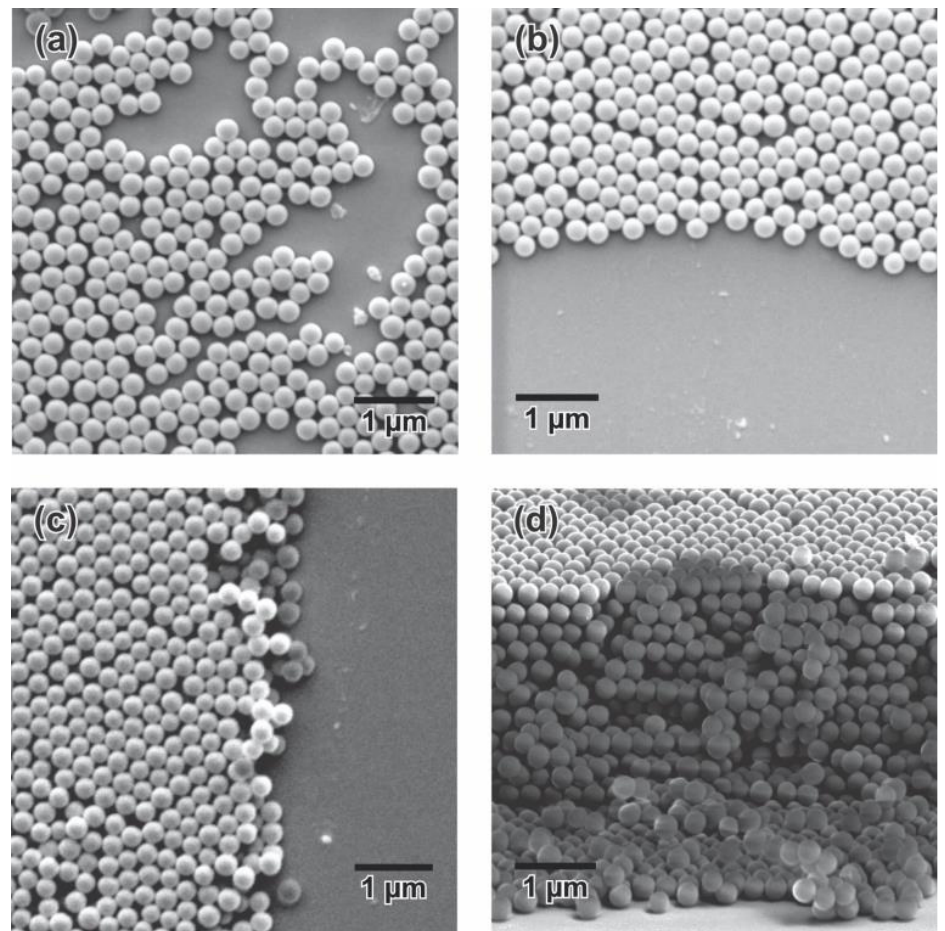
Figure 7. SEM micrograph of C-PCs elaborated at different lifting speeds-SP concentrations: ( a ) 2.39 µ m/s − 1 % SP, ( b ) 2.39 µ m/s − 3 % SP, ( c ) 0.28 µ m/s − 1 % SP, and ( d ) 0.28 µ m/s − 3 % SP.